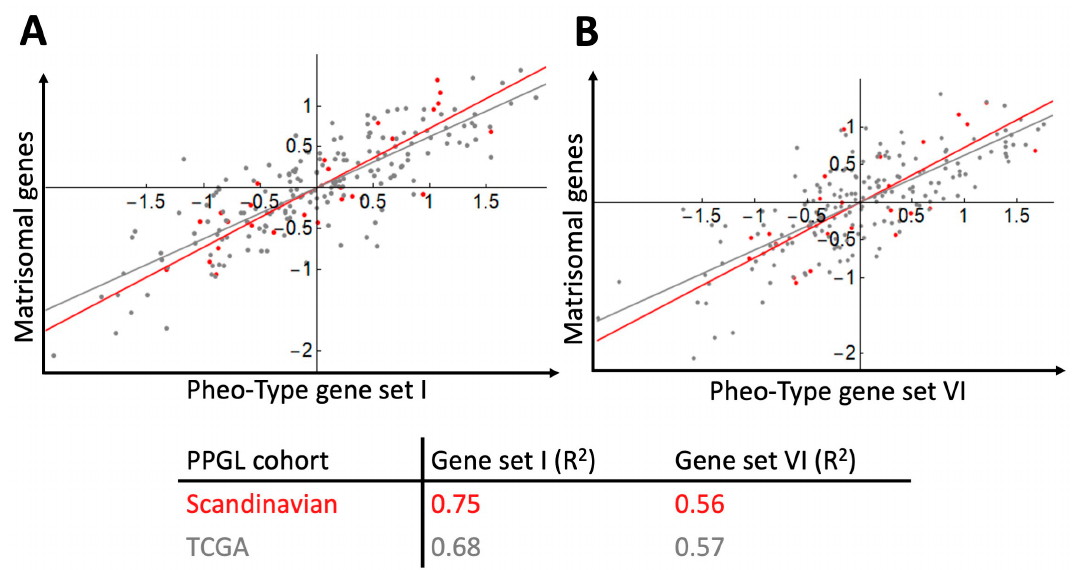
Figure 6. Gene signature scores for PPGL samples (Scandinavian cohort, n = 26, red dots and line; TCGA cohort, n = 186, grey dots and line) and correlation of the matrisomal gene signature downregulated by NRAS in hPheo1 and the pseudohypoxia-related Pheo-Type gene sets I ( A ) and VI ( B ). Correlation coefficients (R 2 ) for each cohort data set are provided.